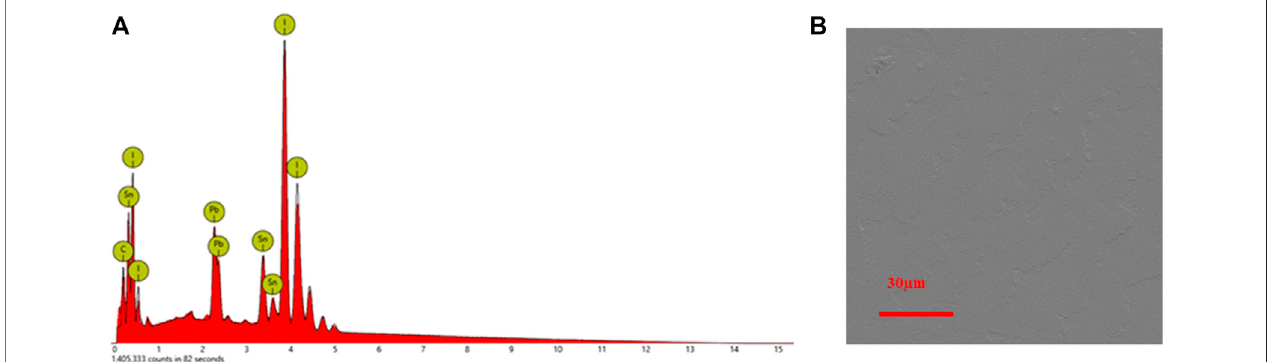
FIGURE 4 | (A) Energy-dispersive X-ray spectroscopy of MAPb 0.5 Sn 0.5 I 3 in (B) surface zone.